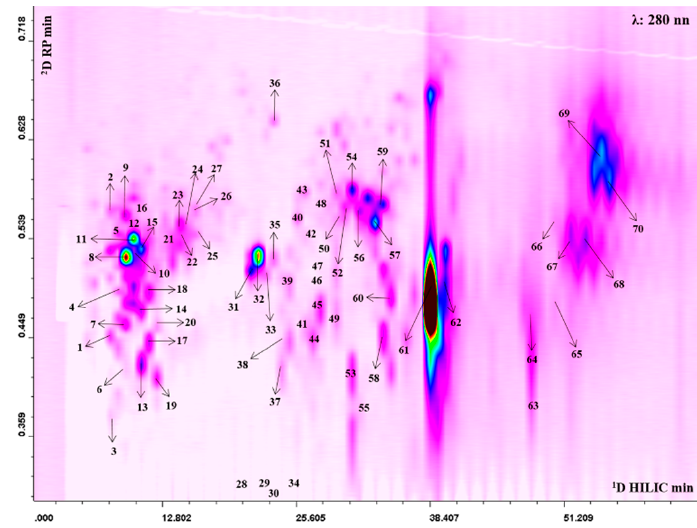
Figure 1. 2D Hydrophilic High performance Liquid Chromatography × Reversed Phase-Ultra High Performance Liquid Chromatography phase (HILIC × RP-UHPLC) counter plot (280 nm) with peak assignment of polyphenols isolated from Punica granatum